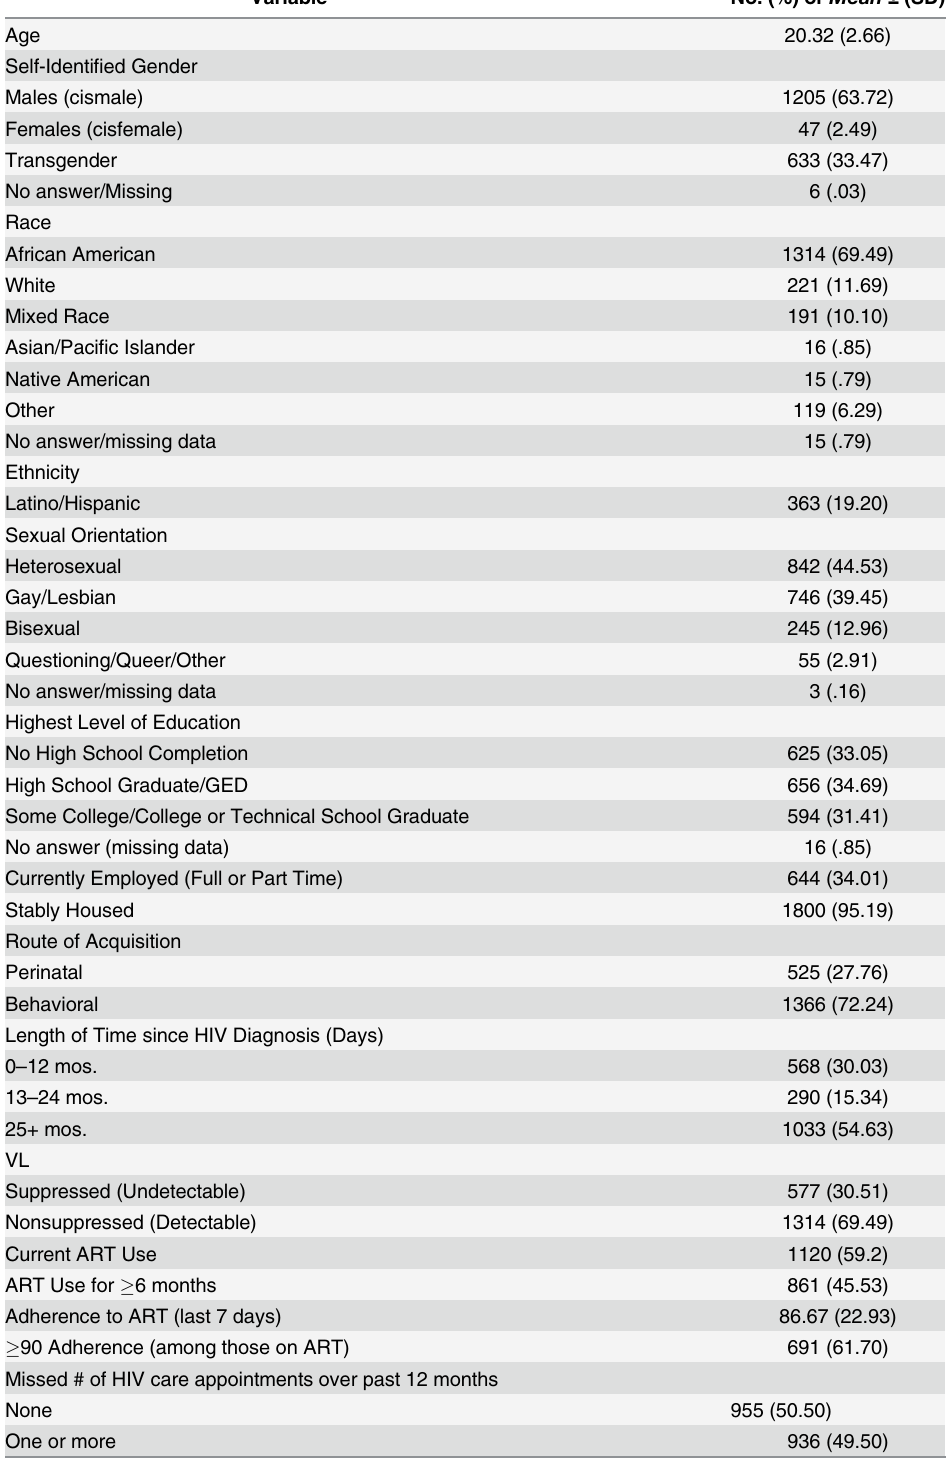
Table 1. Demographic, Biomedical, and Psychosocial/Behavioral Characteristics of Perinatally and Behaviorally HIV-Infected Adolescents and Young Adults Linked to Care (n =